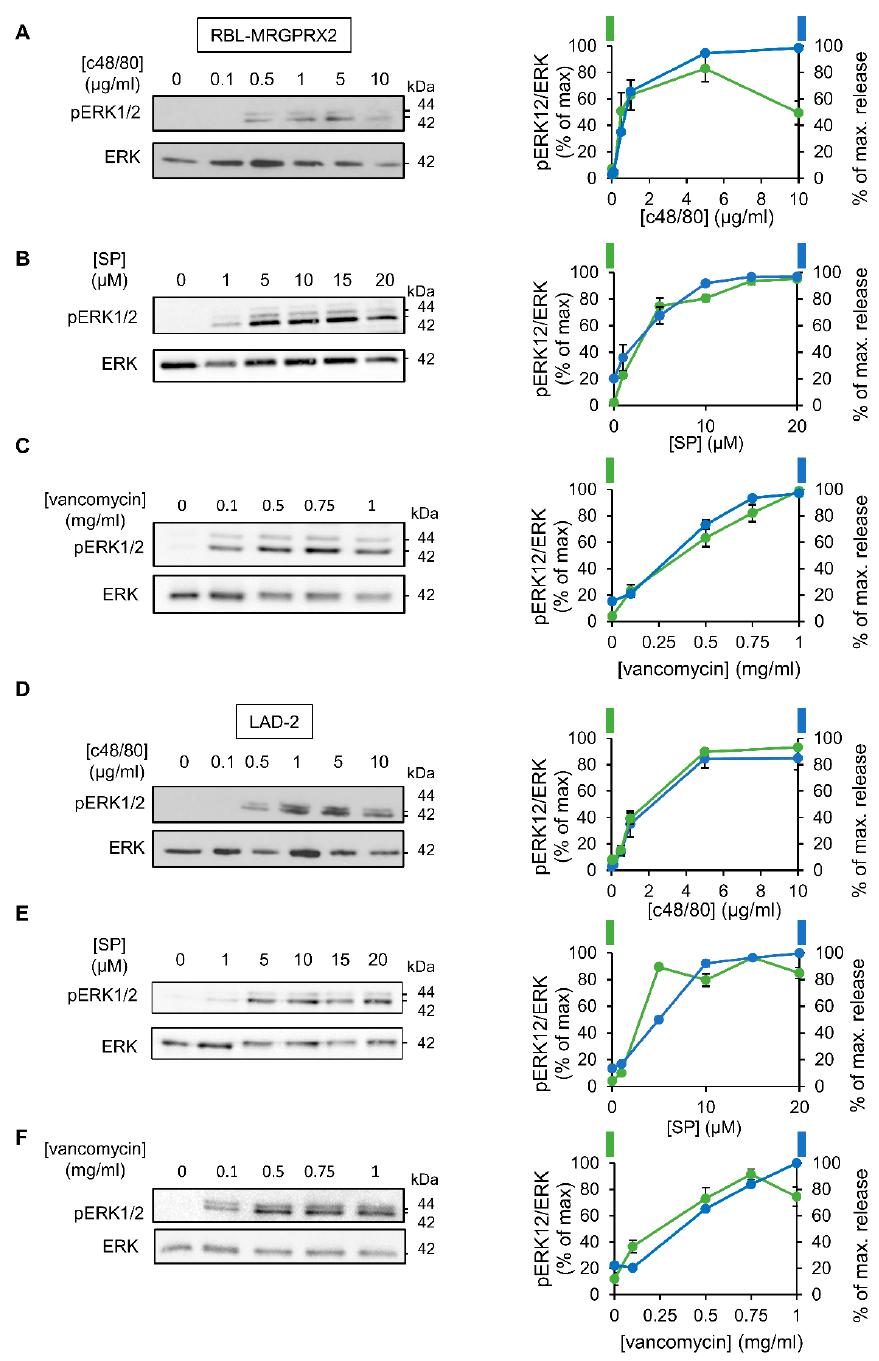
Figure 3. MRGPRX2-stimulated phosphorylation of the ERK1/2 MAP kinases shares similar dose–response relationships in LAD-2 and RBL-MRGPRX2 cells. RBL-MRGPRX2 ( A – C ) and LAD-2 ( D – F ) cells (1 × 10 6 cells/mL) were incubated for 1 min, at 37 ◦ C, with the indicated concentrations of c48/80, SP or vancomycin. Cell lysates were resolved by SDS-PAGE and immunoblotted with anti-pERK1/2 antibodies, followed by reprobing with anti-total-ERK2, as indicated. The intensities of the bands corresponding to phospho-ERK1/2 and total ERK2 were quantified by densitometry, using Image-J software, and the relative pixel densities (phosphorylated/total) were calculated and are presented as percentage of maximal response, in comparison with the percentage of the maximal secretory response at same doses. Data are means ± SEM (n = 3–4). Representative blots are